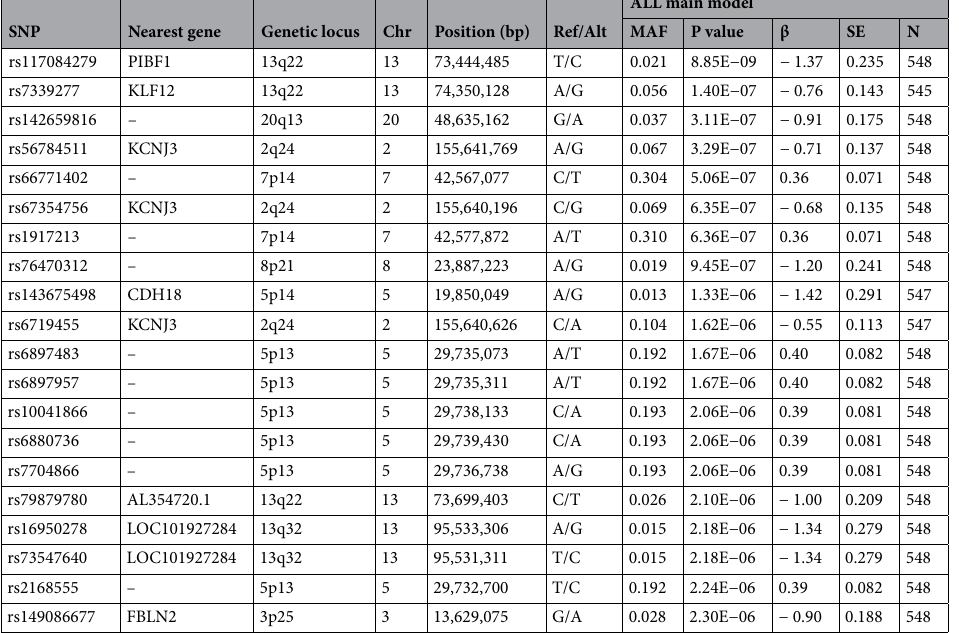
Table 2. Top 20 SNPs of GWAS results in all subjects for emphysema. Model 1 was adjusted for Center, Age, Sex, Smoking event and Pack-years. ALL All patients, LNEI natural logarithm of emphysema index. * P value were less than 5.00E−06.